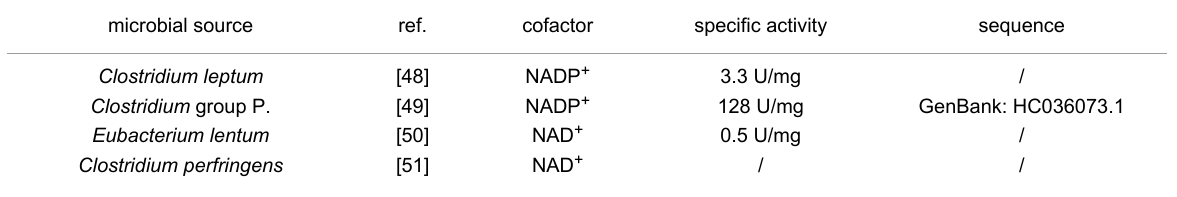
Table 1: Summary of reported 12 α -HSDH. The given activity is based on CA as substrate. microbial source